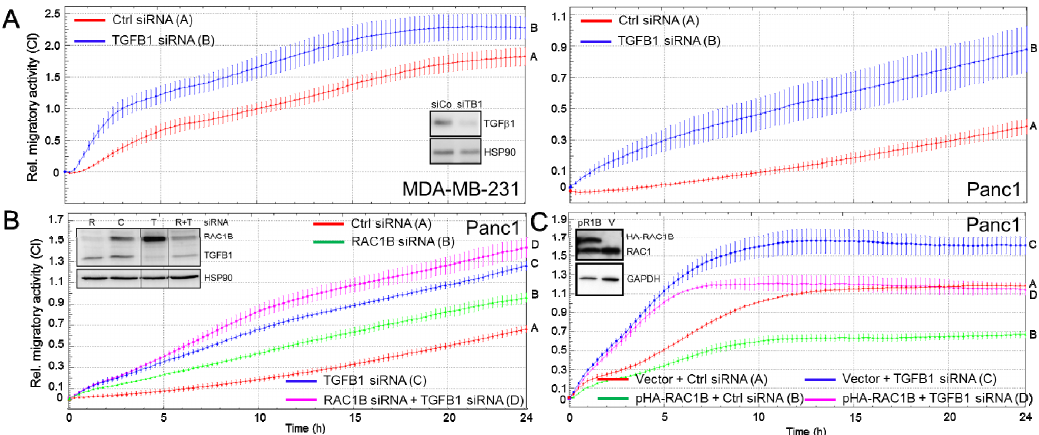
Figure 3. Effect of KD of TGFB1 on random cell migration in MDA-MB-231 and Panc1 cells. ( A ) MDA-MB-231 (left-hand graph) or Panc1 (right-hand graph) cells were transiently transfected twice with 50 nM each of irrelevant ctrl siRNA or TGFB1 siRNA and 48 h later subjected to real-time cell migration assays on an xCELLigence platform. The data shown are each representative of three assays. ( B ) Panc1 cells were transfected with 50 nM of ctrl siRNA, or 25 nM each of TGFB1 siRNA + ctrl siRNA, RAC1B siRNA + ctrl siRNA, or a combination of TGFB1 and RAC1B siRNA, and